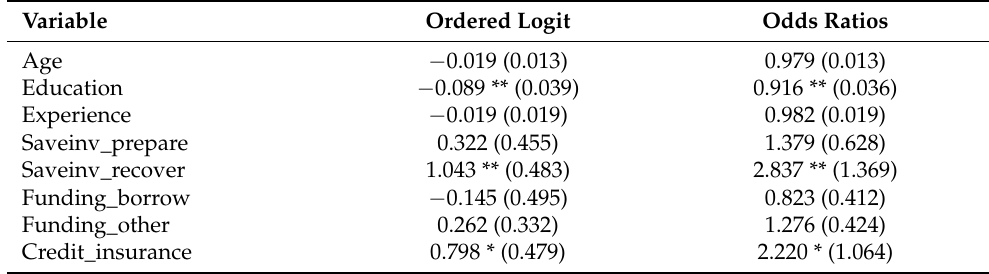
Table A1. Ordered logit regression model results with odds